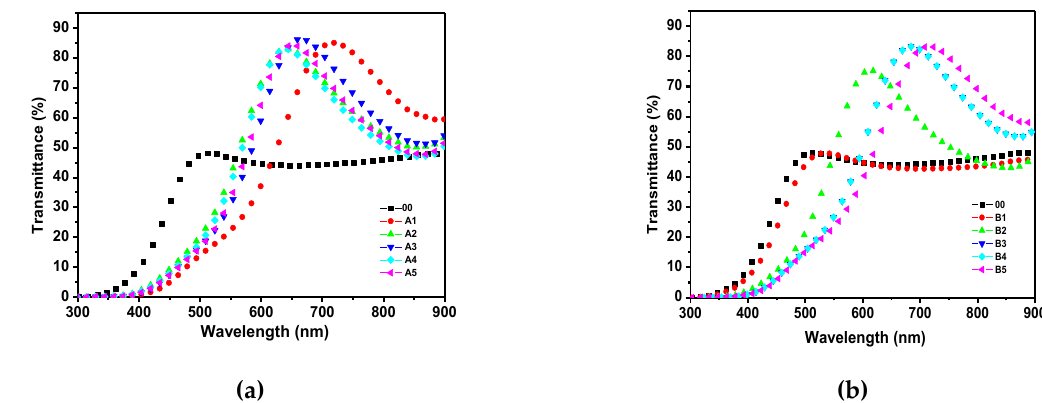
Figure 2. Transmittance vs. wavelength for two series of thin films: ( a ) n-type films with different H 2 and PH 3 contents; ( b ) p-type films with different H 2 and B 2 H 6 contents.